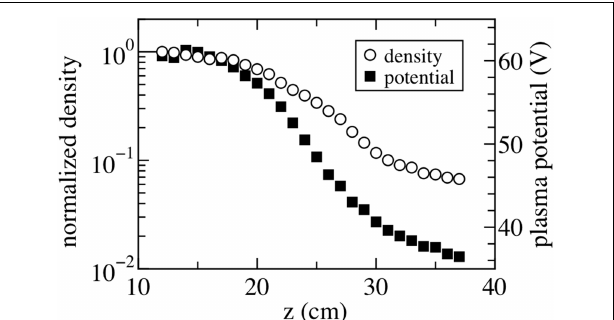
FIGURE 2 | Normalized density (open circles) and potential (filled squares) along the main